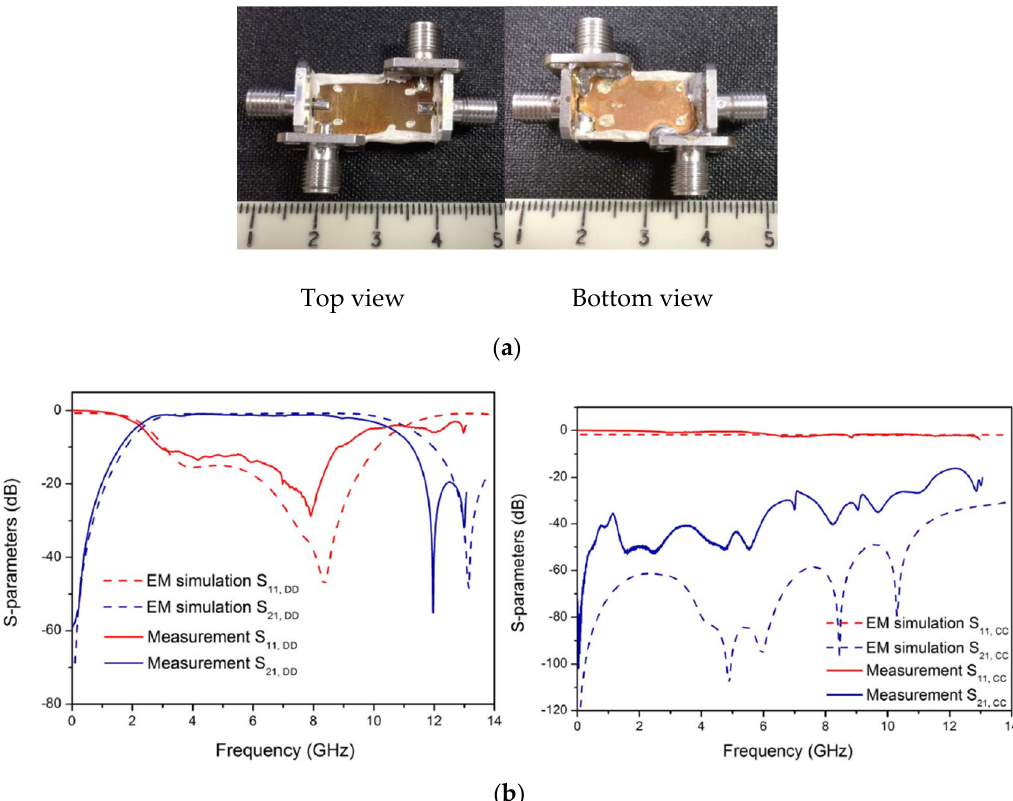
Figure 21. The proposed wide-band balanced BPF [93]: ( a ) Photographs for the prototypes; ( b ) S- Figure 21. parameter performances. ( b ) S-parameter Table 4. Performance comparisons for some recent wide-band and ultra-wideband differential microstrip BPFs.